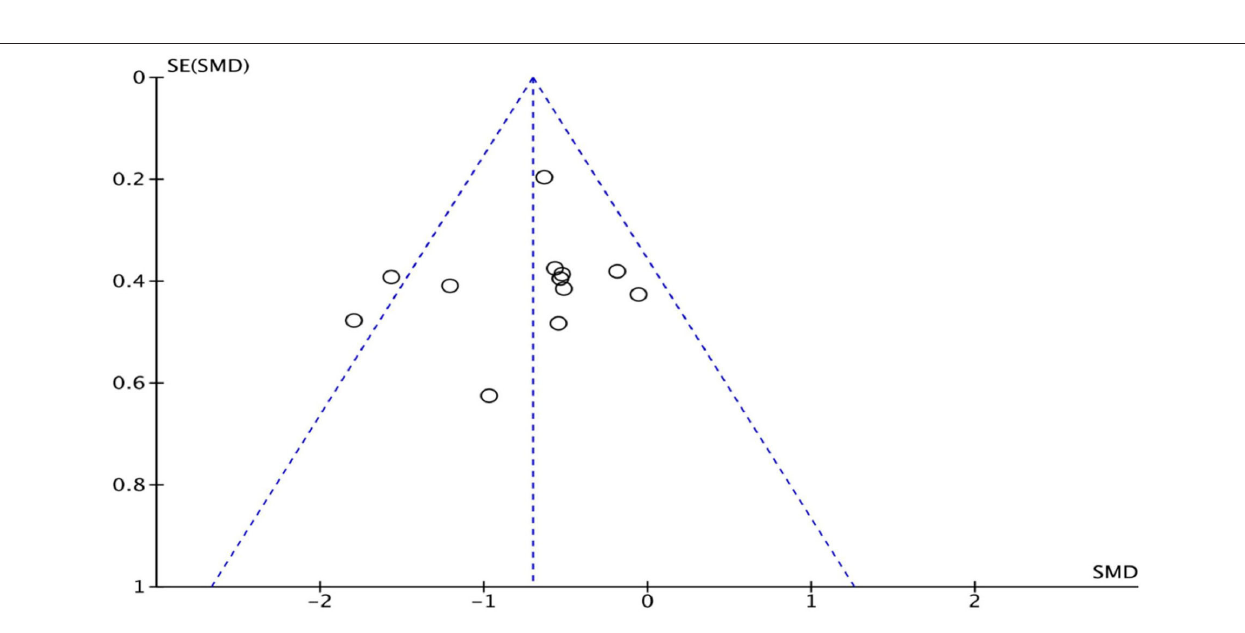
FIGURE 8 | Funnel